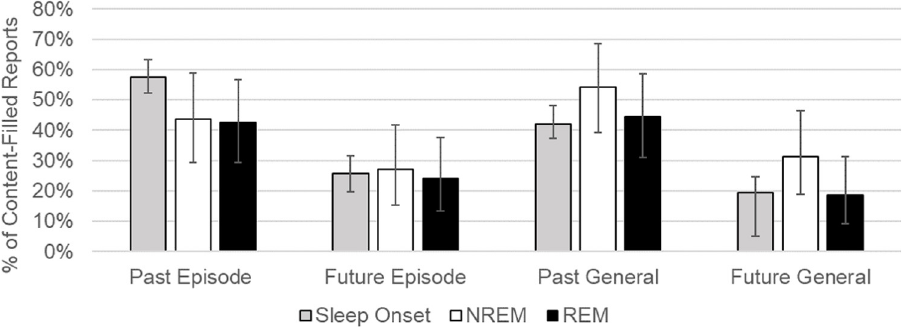
Fig 2. Dream sources by sleep stage. Proportion of content-filled dream reports from each sleep stage by type of waking source. REM = Rapid eye movement sleep. NREM = Non-rapid eye movement sleep. Error bars = 95% CI. Binomial confidence intervals calculated using the Clopper–Pearson “exact”